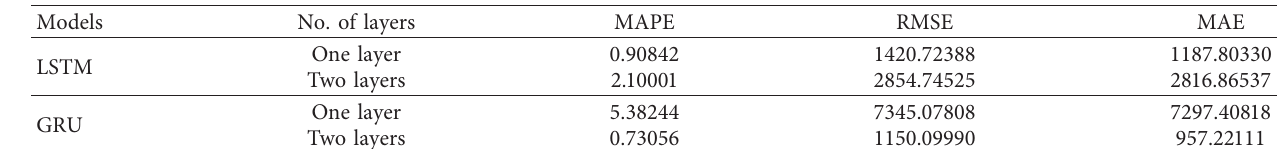
Table 11: The results of DL for confirmed cases in Kuwait.